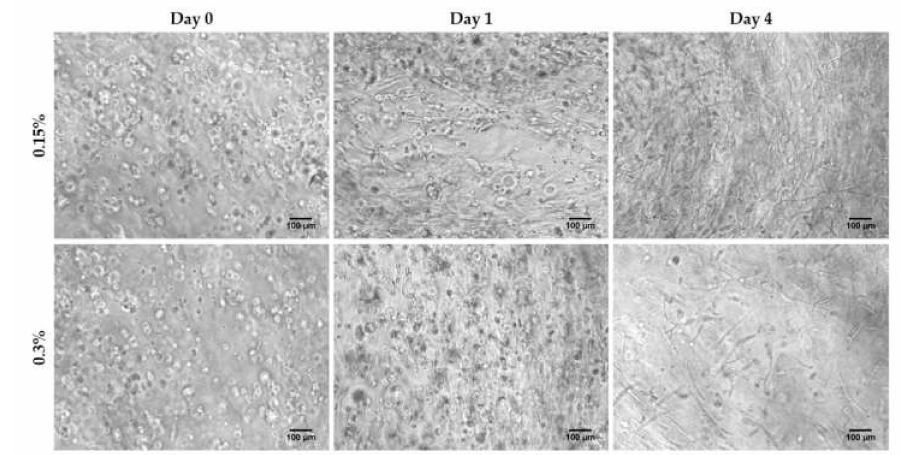
Figure 1. HFDPC cultured in 3D self-assembling peptide sca ff old RAD16-I at 0.15% and 0.3% peptide concentration. Scale bar 100 µ m.